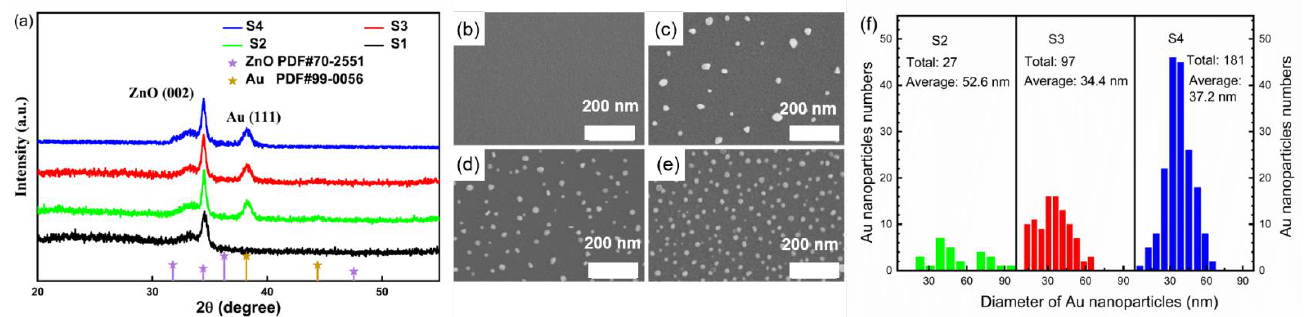
Figure 2. XRD patterns of as-obtained samples ( a ) and high-resolution SEM images of S1 ( b ); S2 ( c ); S3 ( d ); S4 ( e ); size distribution of Au nanoparticles ( f ). S3 ( d ); S4 ( e ); size distribution of Au nanoparticles ( f